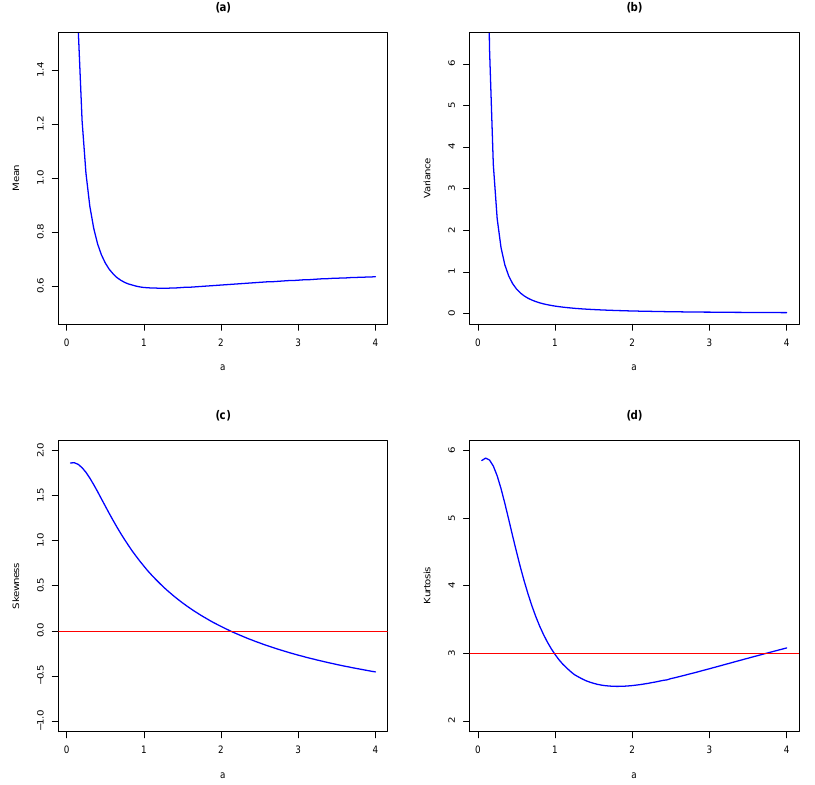
Figure 3. Plots of ( a ) Mean, ( b ) variance, ( c ) skewness and ( d ) kurtosis of MKiEx distribution as a function of a and for λ =